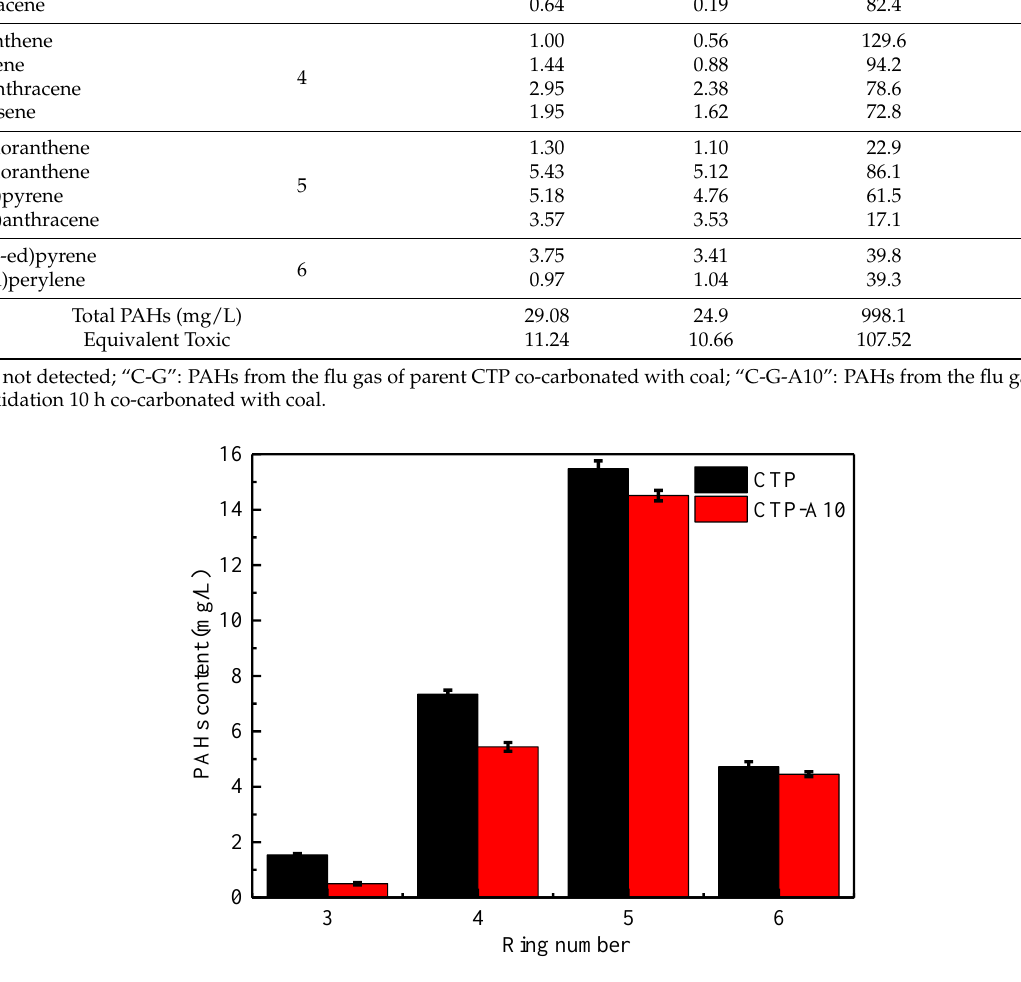
Figure 7. Change rate of PAHs with different ring numbers in CTP after catalytic air oxidation for 10 h. From Table 7, the proportion of PAHs with a molecular mass between 178 and 278 in CTP is increased after air oxidation, which is beneficial to enhance the coal expansion rate to fill the void between coal particles, thereby increasing the contact between them and reducing the escape of gas during the carbonization process [56]. The PAHs produced by co-carbonization are mainly four-ring aromatic hydrocarbons, shown in Figure 8 [34,35]. The use of air catalytic oxidation CTP significantly reduces the emission of PAHs during the co-carbonization process, which is of great meaningful results for environmental pol- lution prevention and control of the coking industry.